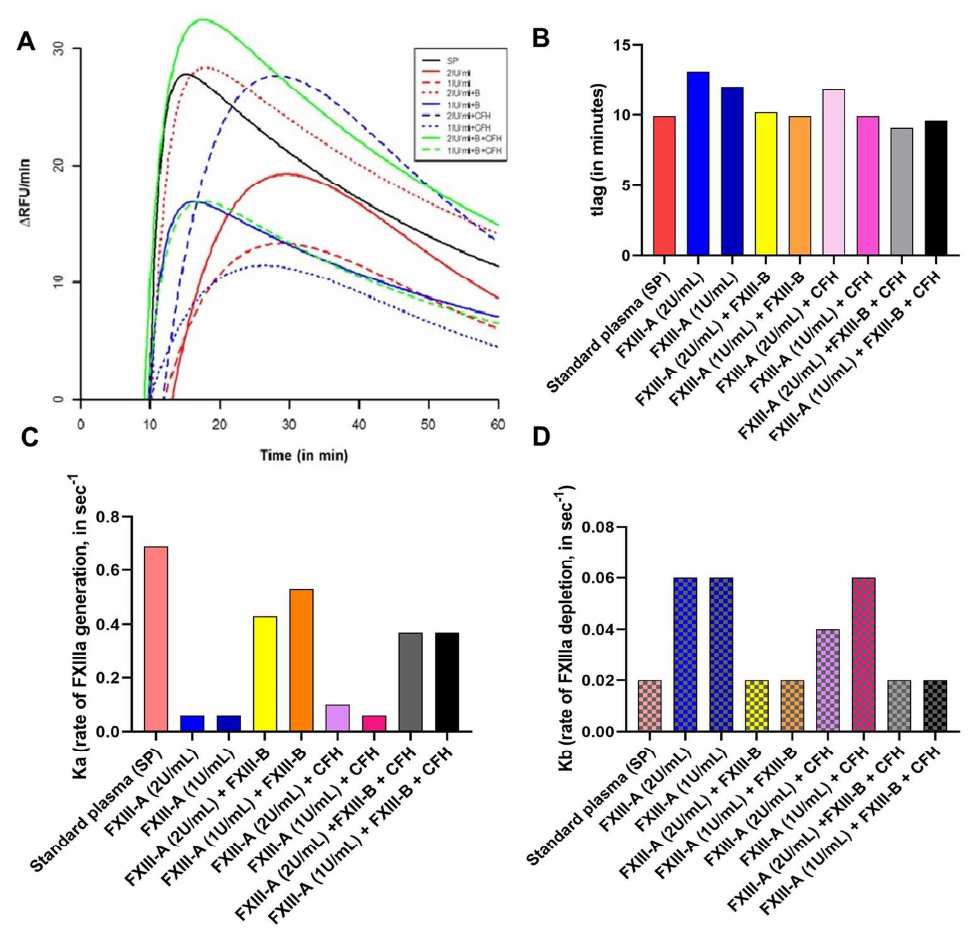
Figure 3. Effect of Complement Factor H (CFH) on FXIIIa generation. FXIIIa generation assay is a